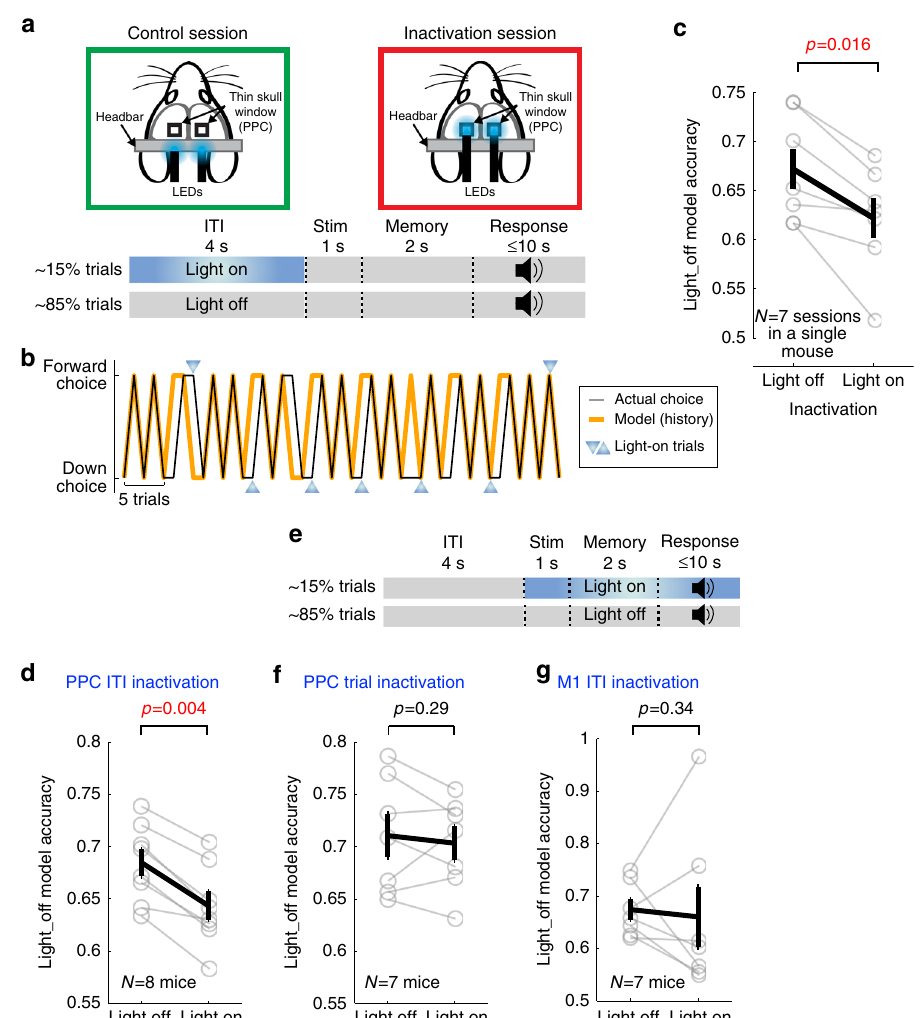
Fig. 7 Inactivating pre-stimulus activity in PPC alters internal bias. a Schematic of inactivation experiment. Control (blue light directed away from PPC) and inactivation (the light directed to PPC) sessions alternated day-to-day (for 14 – 16 days). Continuous blue light was applied during the ITI in randomly selected trials (15%; light-on trials) in both control and inactivation sessions. b Choice sequence (black) and behavioral model fi t (orange) in an example inactivation session. In this example, the mouse tended to alternate choice (i.e., the mouse most heavily weighted the previous choice history) in light-off trials, but this tendency was reduced in light-on trials. c The effect of PPC ITI inactivation on the model fi t in seven separate inactivation sessions in a single mouse. Black, mean ± s.e.m. across sessions; gray, individual sessions. Wilcoxon signed rank test. The light-off model was built on a subset of light-off trials and its accuracy was assessed on the remaining light-off or light-on trials. d Average light-off model accuracy in light-off and light-on trials in inactivation sessions. Black, mean ± s.e.m. across mice; gray, individual mice. Wilcoxon one-sided signed rank test. e In trial inactivation sessions, blue light was applied from stimulus onset to the end of randomly selected trials (15%). Trial inactivation does not have a temporal overlap with ITI inactivation. f The same as d , but for trial inactivation in PPC. g The same as d , but for ITI inactivation in